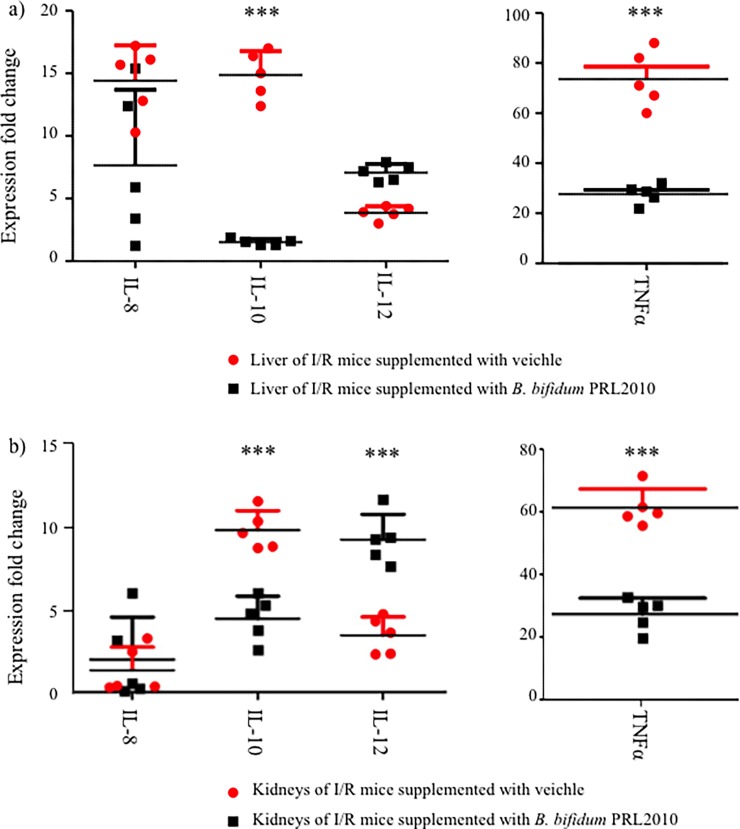
Effects of B. bifidum PRL2010 on the cytokine response in I/R mice.Panel a displays the relative transcription levels of IL-8, IL-10, IL-12 and TNFalpha in the liver of I/R mice supplemented with vehicle (designated with red circles) or with B. bifidum PRL2010 (designated with black squares). Panel b shows the relative transcription levels of the same cytokines in the kidneys of I/R mice supplemented with vehicle (red circles) or with B. bifidum PRL2010 (black squares). ***P<0.001 vs. vehicle-treated I/R mice, Student’s t-test. The y-axis represents the normalized expression level (ΔCt) according to CFX96 Bio-Rad software.